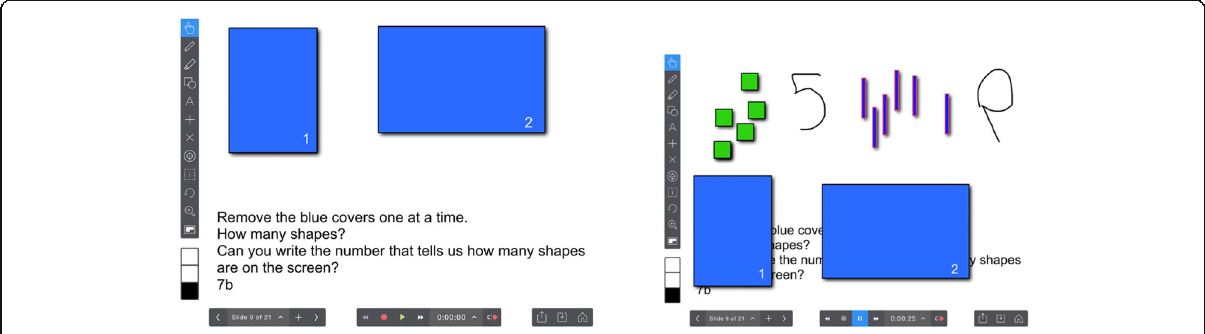
Fig. 2 Original test item and test item after answered by student